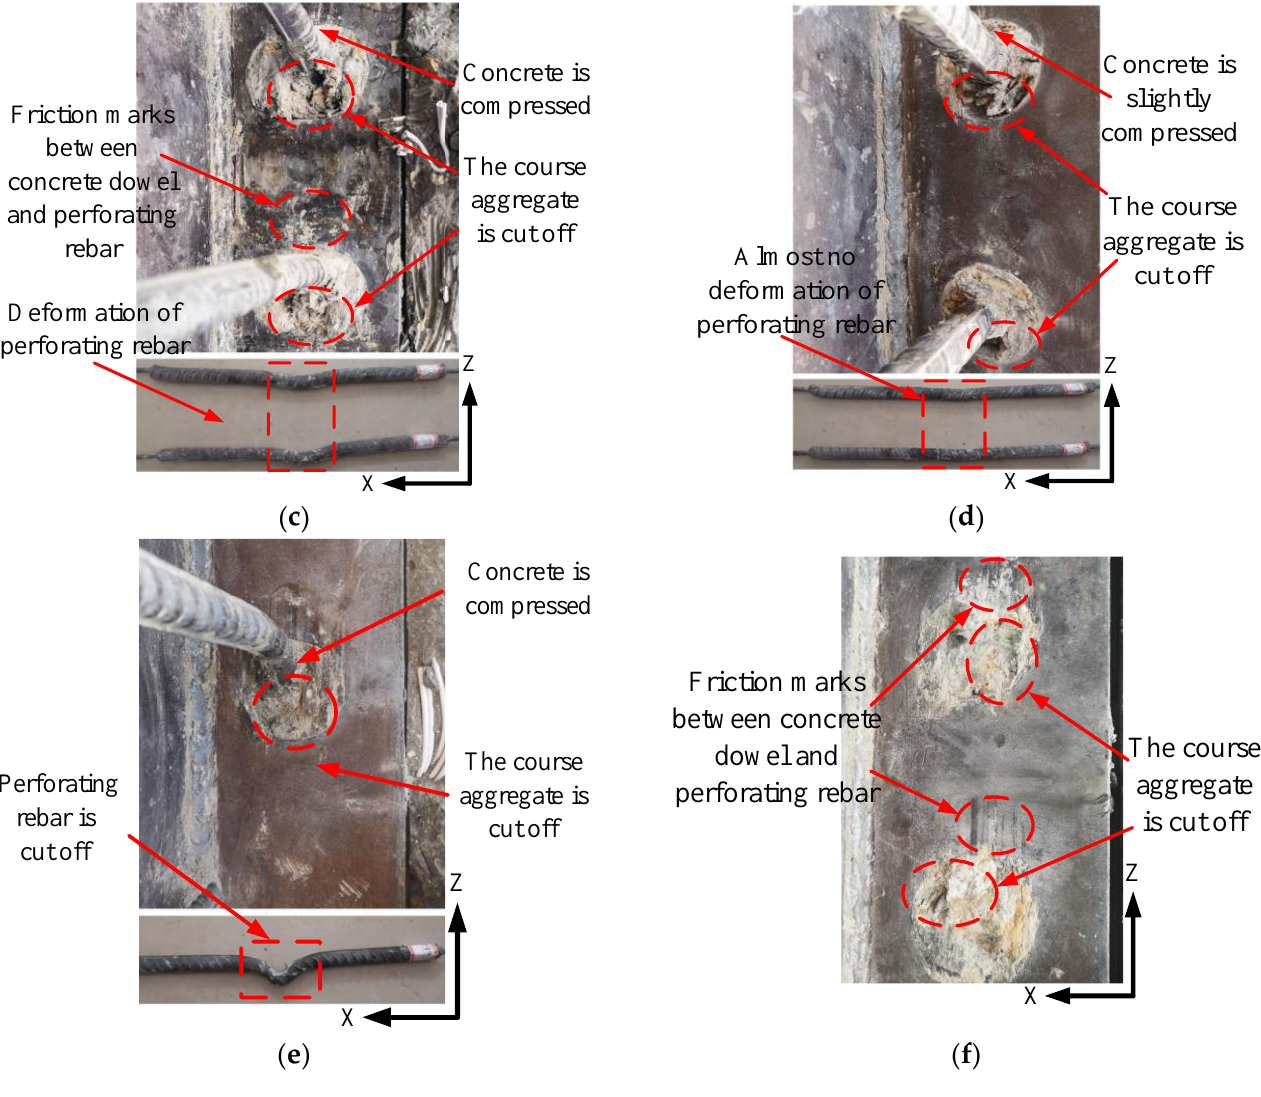
Figure 8. Inner failure modes of the perfobond connectors : ( a ) Inner failure mode of specimens with circular hole ; ( b ) Inner failure mode of specimens with long hole ; ( c ) Inner failure mode of specimens with high hole ; ( d ) Inner failure mode of specimens without stirrups; ( e ) Inner failure mode of specimens with single hole; ( f ) Inner failure mode of specimens without perforating rebar.